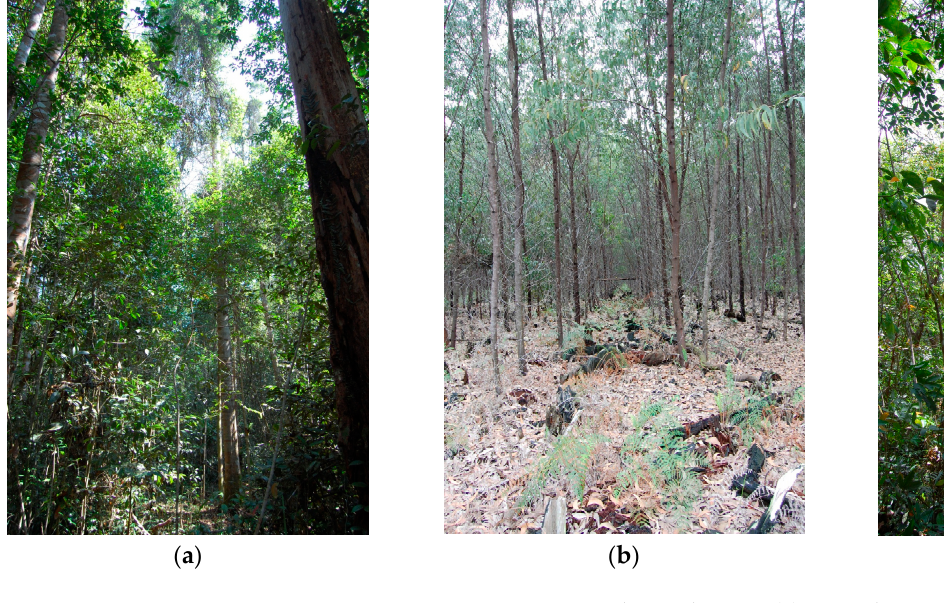
Figure 2. Forest cover types in the study area: ( a ) natural peat swamp forests (NPF), ( b ) planted acacia forests (PAF), and ( c ) jungle rubber forests (JRF).